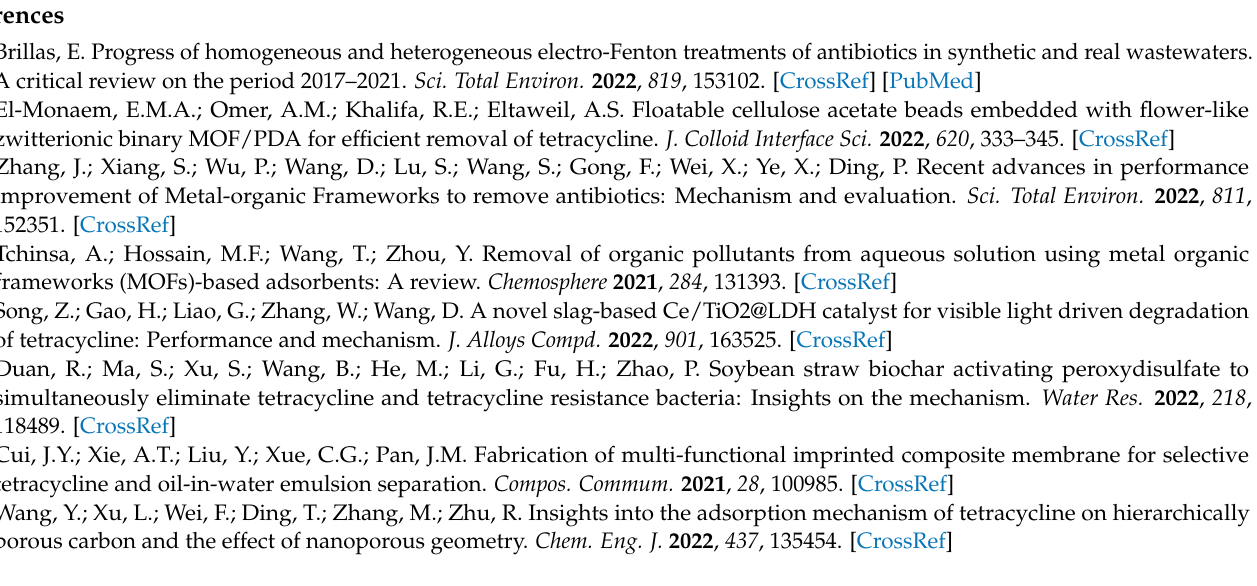
Figure S2: SEM images of Alg-Cu and the elemental distributions of C, O, and Cu; Figure S3: SEM images of Alg-Cu@GO and the elemental distributions of C, O, and Cu; Figure S4: XRD patterns of GO; Figure S5: FTIR spectra of GO, Alg-Cu, and TC; Figure S6: Molecular size of different pollutants optimized by Martials